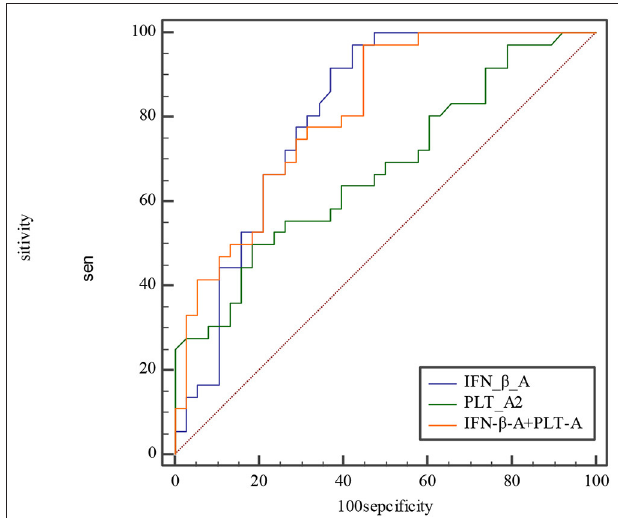
FIGURE 5 | Comparison of ROC at acute phase between IFN- β , PLT, and combined IFN- β and PLT. The AUC of IFN- β , PLT, and combined IFN- β and PLT is 0.809, 0.679, and 0.812, with 0.701–0.891, 0.560–0.783, 0.704–0.894 for their 95% CI separately. The difference of AUC between IFN- β and PLT is about 0.13, Z ≈ 1.57, P ≈ 0.12. The difference of AUC between IFN- β and combined IFN- β and PLT is about 0.003, Z ≈ 0.08, P ≈ 0.93. The difference of AUC between PLT and combined IFN- β and PLT is about 0.13, Z ≈ 2.558, P ≈ 0.01.